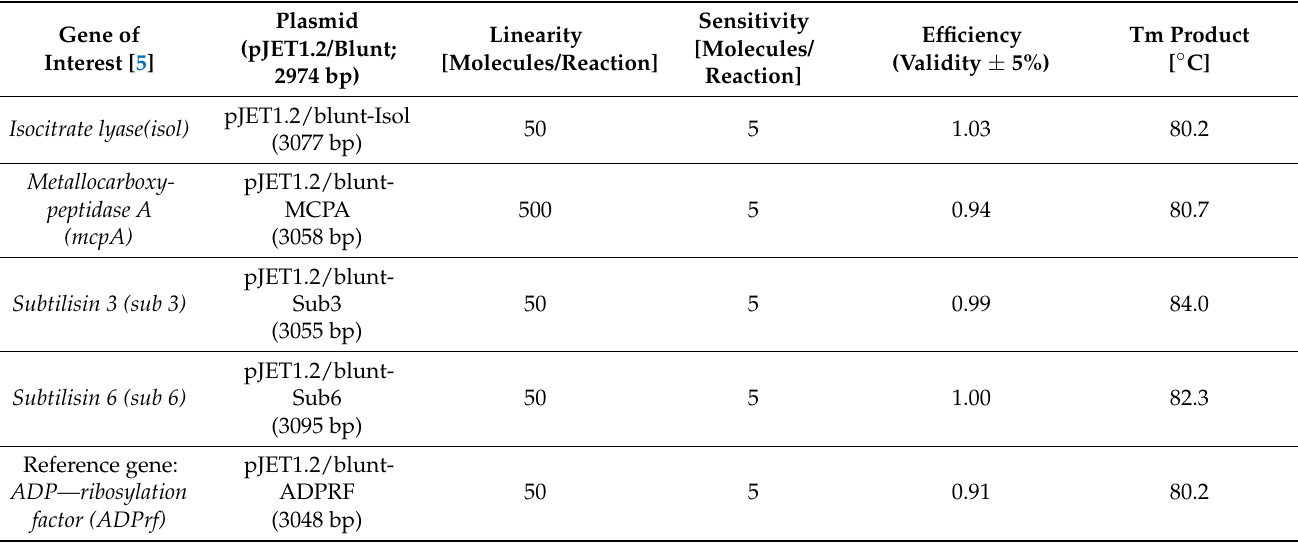
Table 2. Characteristics of the established